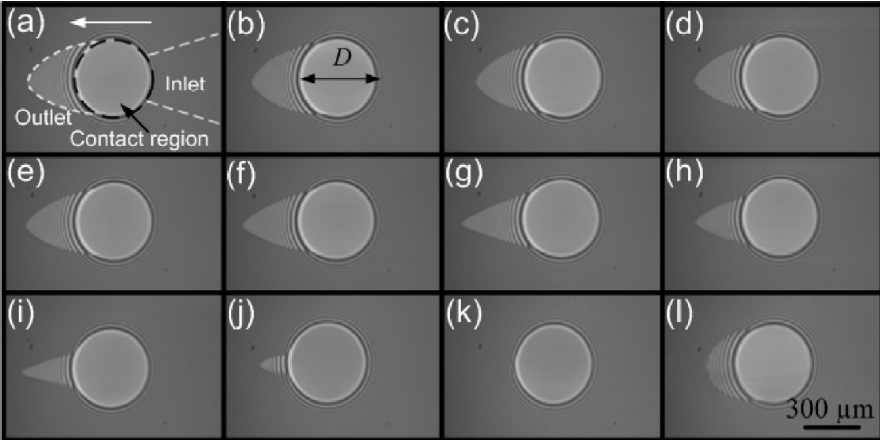
Fig. 21 “Freezing” of liquid in a nano gap by using n-hexadecane under different dc voltages, observed by Xie et al. (a) 0 V, (b) 10 V, (c) 20 V, (d) 30 V, (e) 40 V, (f) 50 V, (g) 60 V, (h) 70 V, (i) 80 V, (j) 90 V, (k) 98 V, and (l) 10 s after the removal of the EF [94]. Copyright 2010, American Chemical